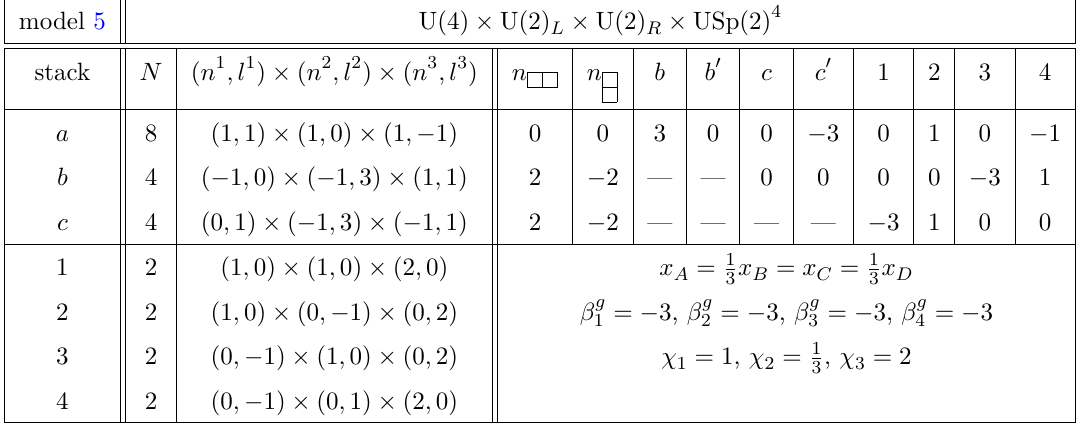
Table 5 . D6-brane configurations and intersection numbers of Model 5, and its MSSM gauge